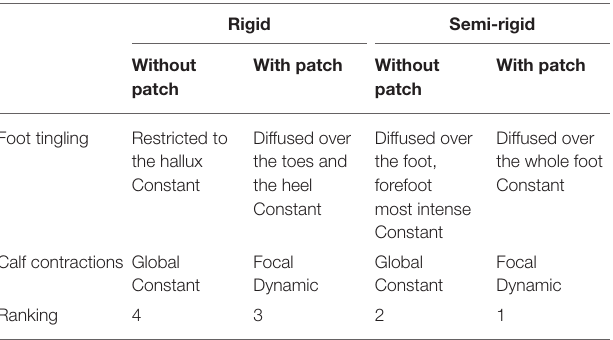
TABLE 1 | Description of the participant’s phantom sensations according to the 4 prosthetic interface conditions.